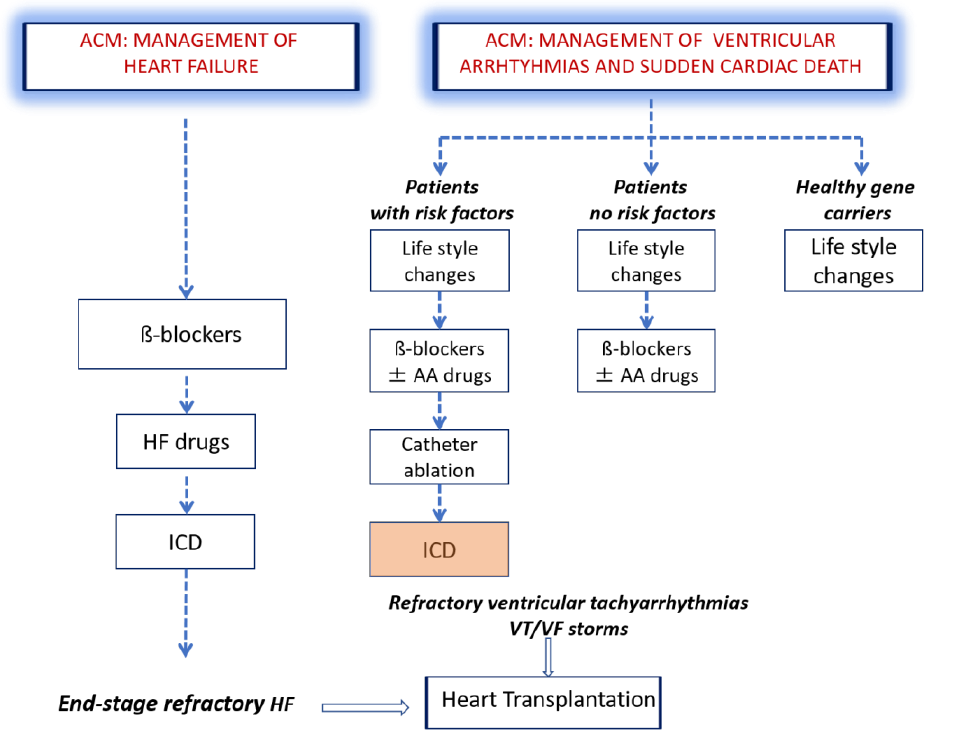
Figure 2. Flow chart of treatment of patients with ACM. Both healthy gene carriers and ACM patients should avoid intense sport activity, to prevent exercise-induced arrhythmic events and disease development or progression. Betablockers, since they prevent arrhythmic events and lower right ventricular wall stress, are essential drugs to be used in all clinically affected individuals. In patients suffering from VAs, AA drugs give the opportunity to improve symptoms. Catheter ablation is an interventional option for patients with episodes of sustained monomorphic VT. Patients for whom the implantation of an ICD is most often indicated are those with history of VF or sustained VT. In advanced stages of the disease, when HF occurs, betablockers and other HF drugs are indicated. AA drugs = antiarrhythmic drugs; ACM = arrhythmogenic cardiomyopathy; HF = heart failure; ICD = implantable cardioverter defibrillator; Vas = ventricular arrhythmias; VT = ventricular tachycardia; VF = ventricular